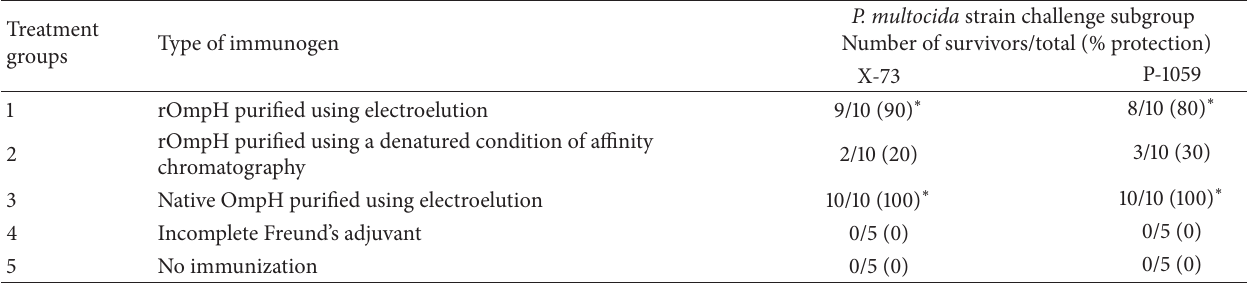
Table 1: Experimental design and results of P. multocida challenge of immunized and nonimmunized chickens.